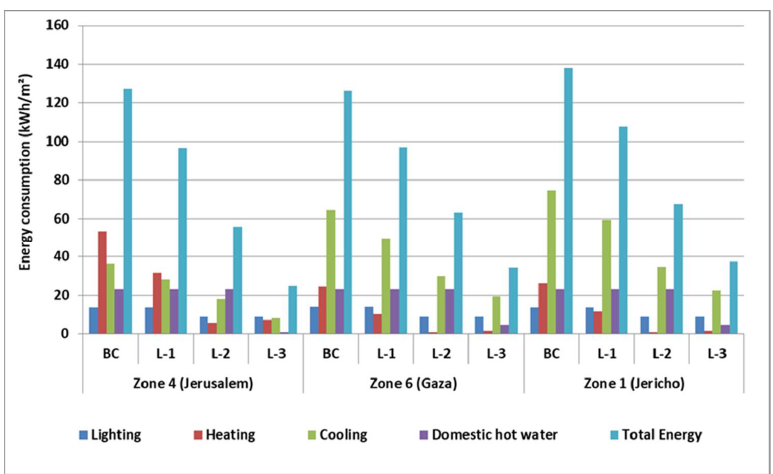
Figure 5. Total energy saving from applying the retrofitting plan for four residential units per floor area in different climate zones in Palestine.